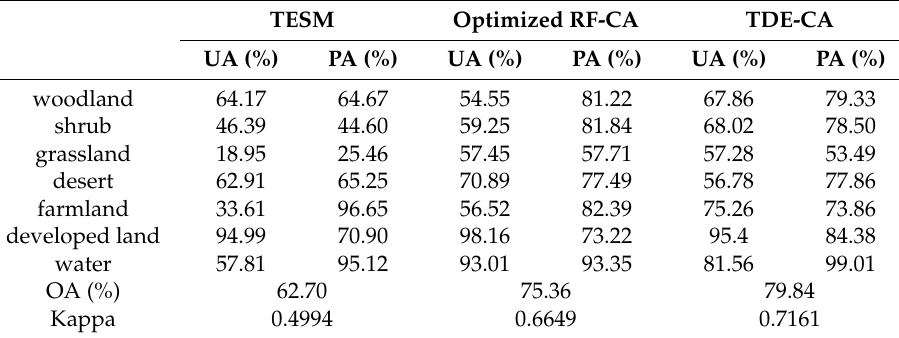
Table 5. The accuracies comparison of the TDE-CA and its